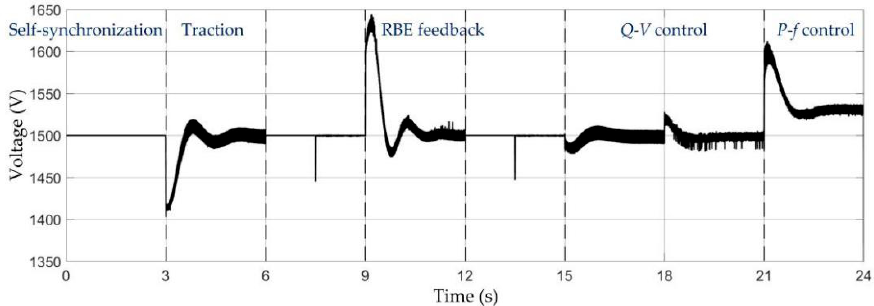
Figure 15. The DC bus voltage of the system.